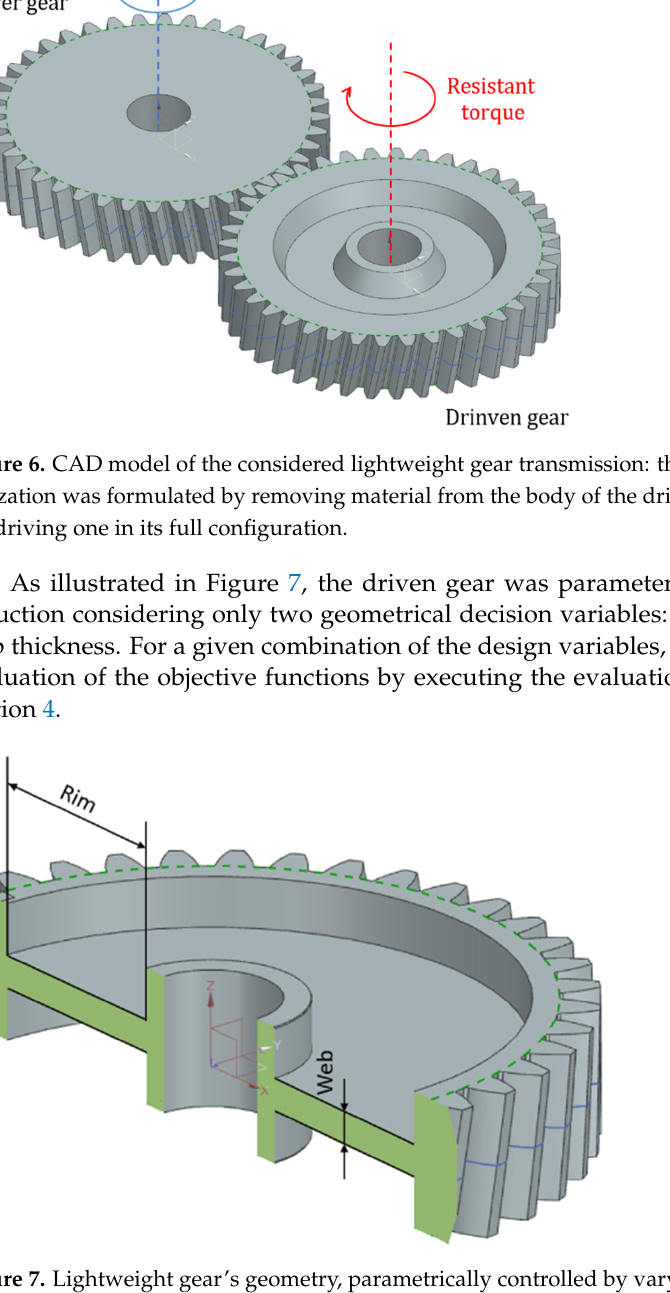
Figure 7. Lightweight gear’s geometry, parametrically controlled by varying two decision variables: rim length and web thickness.